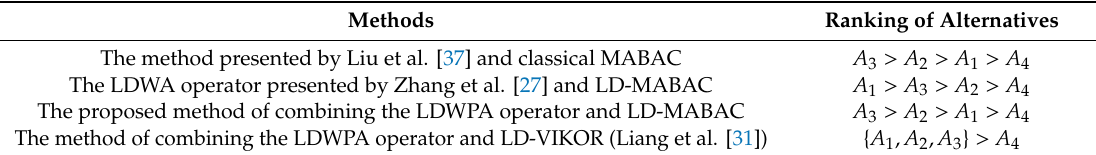
Table 9. Comparison of the results obtained using the four combined